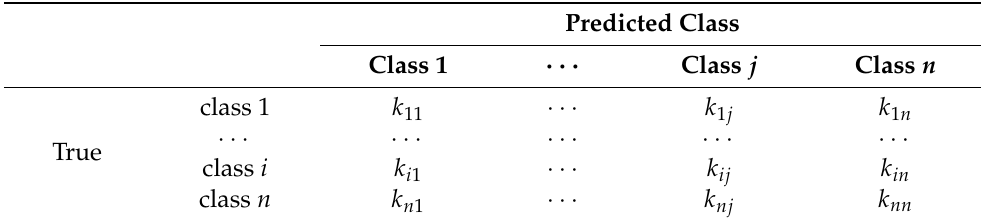
Table 1. The confusion matrix of multiclass